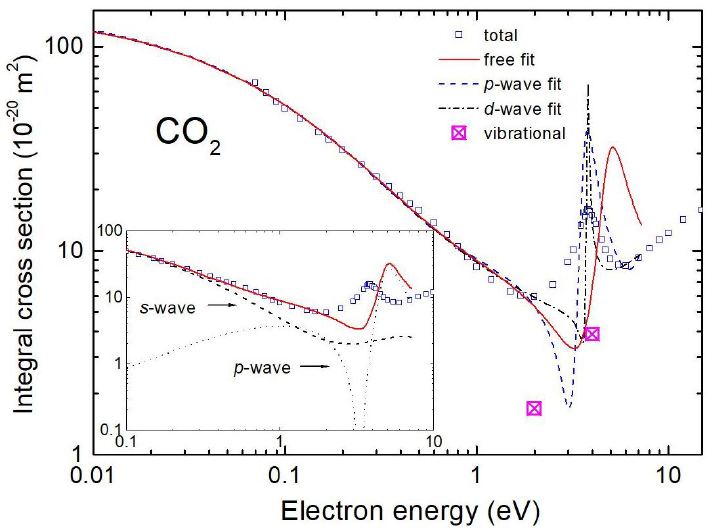
Figure 2. Integral (elastic and vibrational) cross sections for electron—CO 2 scattering in the low energy range. As for N 2 , the MERT analysis [40] predicts a shape resonance. Elastic cross sections re-edited from reference [40], vibrational—measurements from the Kaiserslautern group [44], TCS— recommended values from reference